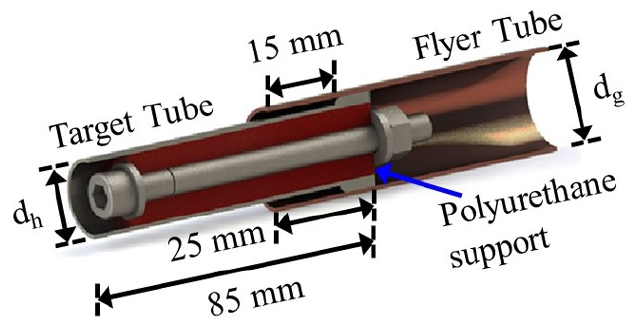
Figure 4. Schematic representation of the tubular internal support used in the experiments with flyer tube diameter d g = 22.22 mm and target tube diameter d h = 16.44 to 18.44 mm. Table 2. Material properties of coil, field shaper and tubes (flyer-target) [10].